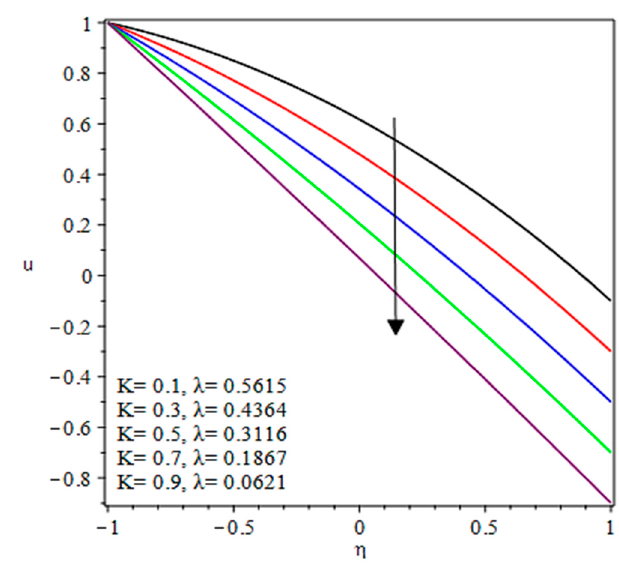
ξ= 0 ξ= 0 by fixing = 0.2 M and by fixing = 0.2 M and